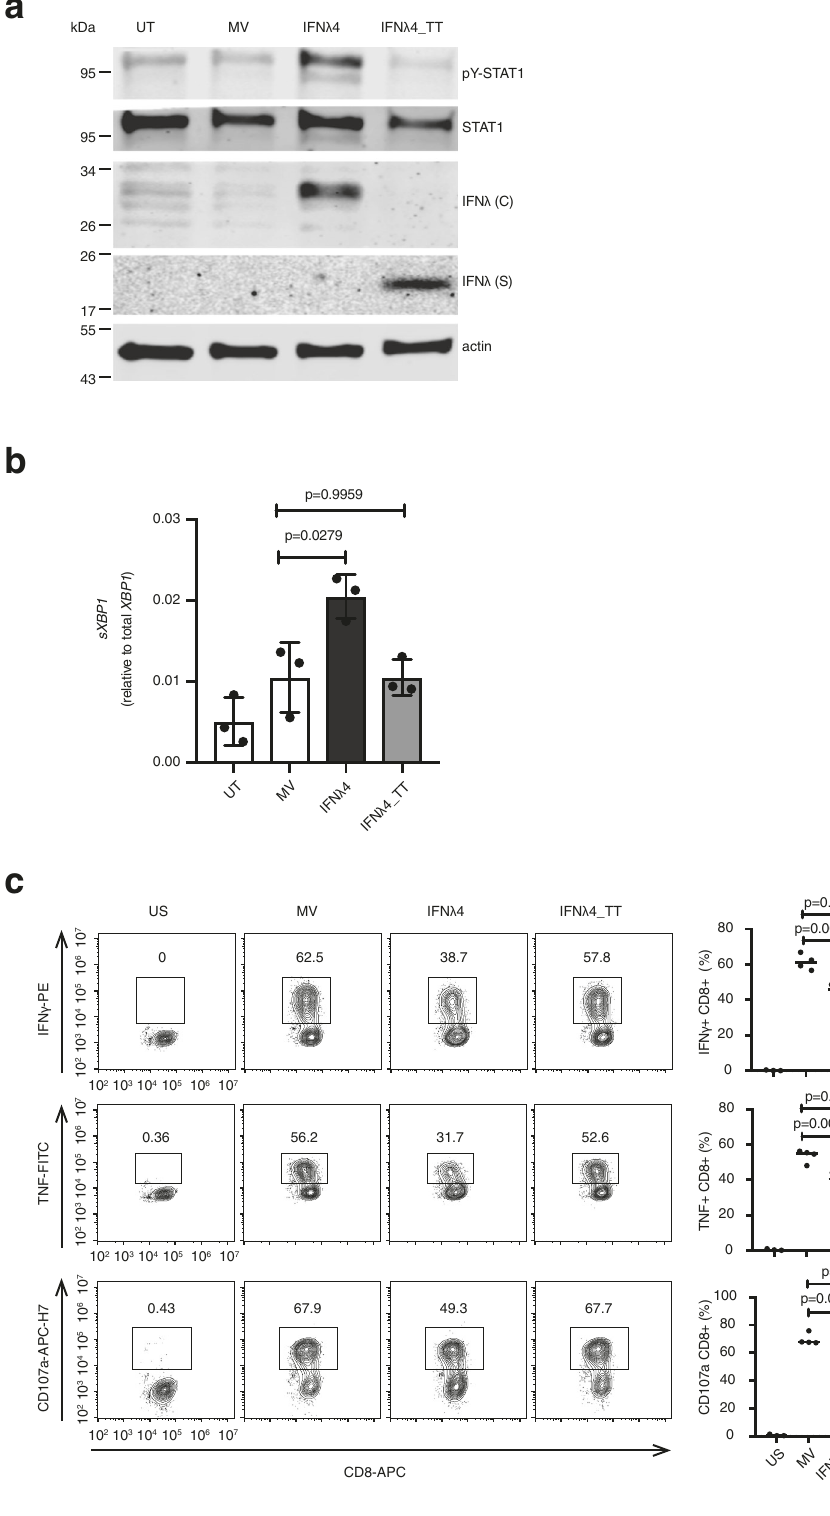
by silver staining was used for all subsequent experiments and quanti fi cation of puri fi ed IFN λ 4. The quanti fi cation of the puri fi ed IFN λ 4 and IFN λ 3 preparation was con fi rmed by silver staining after separation by 12% SDS-PAGE (Supplementary Fig. 3f). E. coli -derived IFN λ 3 and IFN λ 4 proteins harboring N-terminal 6× His tags were kindly provided as a gift by Prof. Rune Hartmann 10 . The Fiji distribution of ImageJ 42 was used for protein quanti fi cation of silver staining and western blot